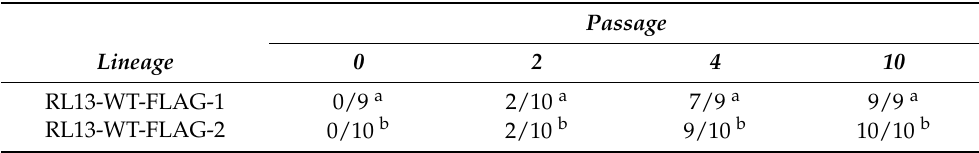
Table 2. Emergence of mutations altering RL13 expression or localization.